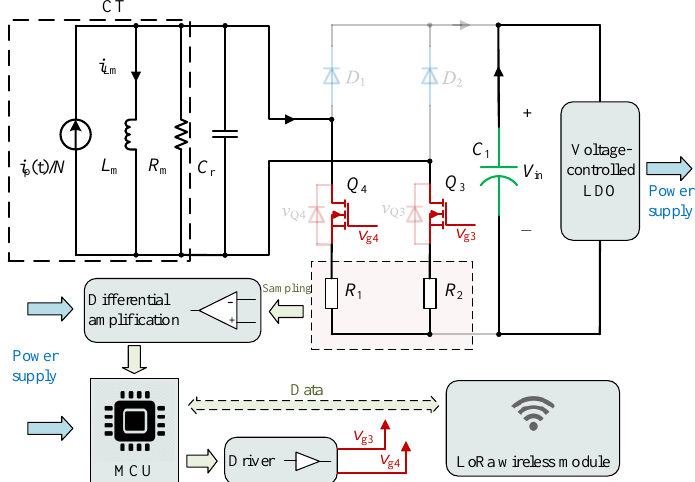
Figure 12. The equivalent circuit of the system operating in current measurement mode.